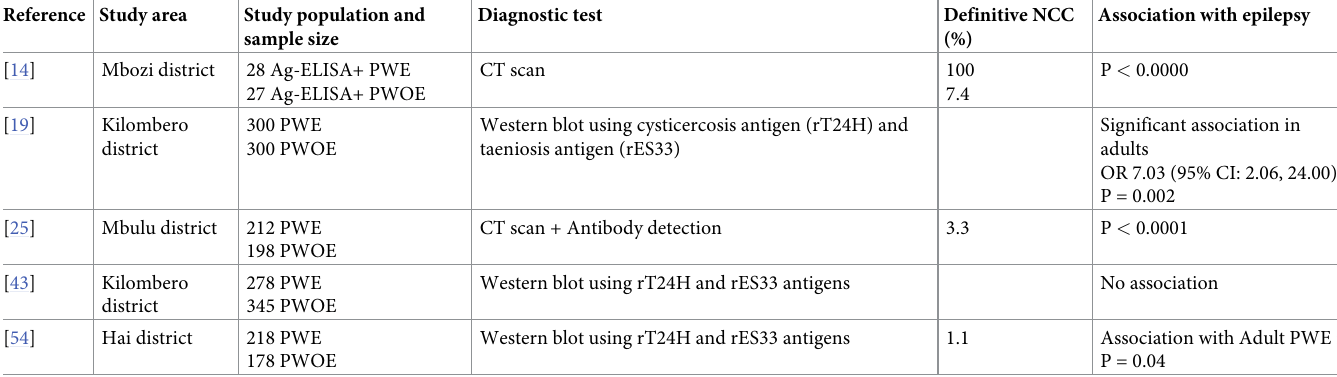
Table 2. Prevalence of neurocysticercosis (NCC) in people with epilepsy (PWE) and without epilepsy (PWOE), Tanzania, 1995–2018. Reference Study